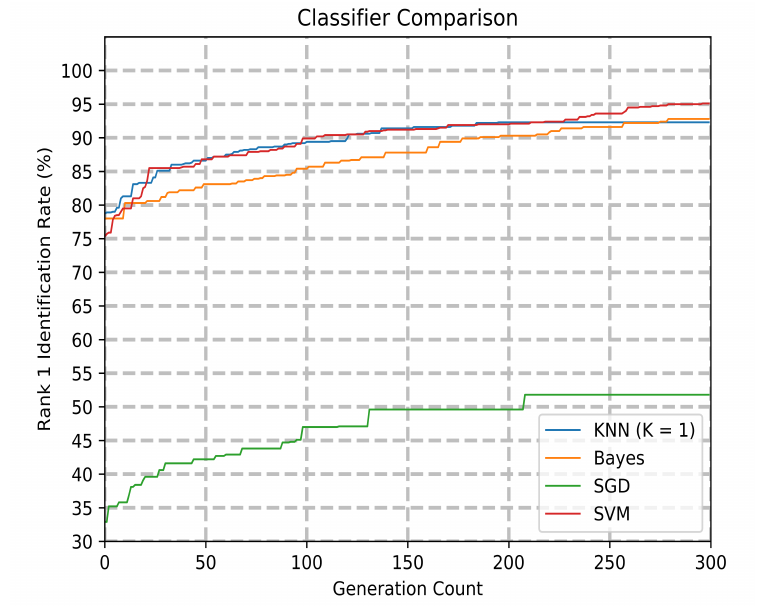
Figure 8. Model accuracy comparing different classifiers. Table 3. Summary comparison of rank 1 accuracy between different classifiers used in the